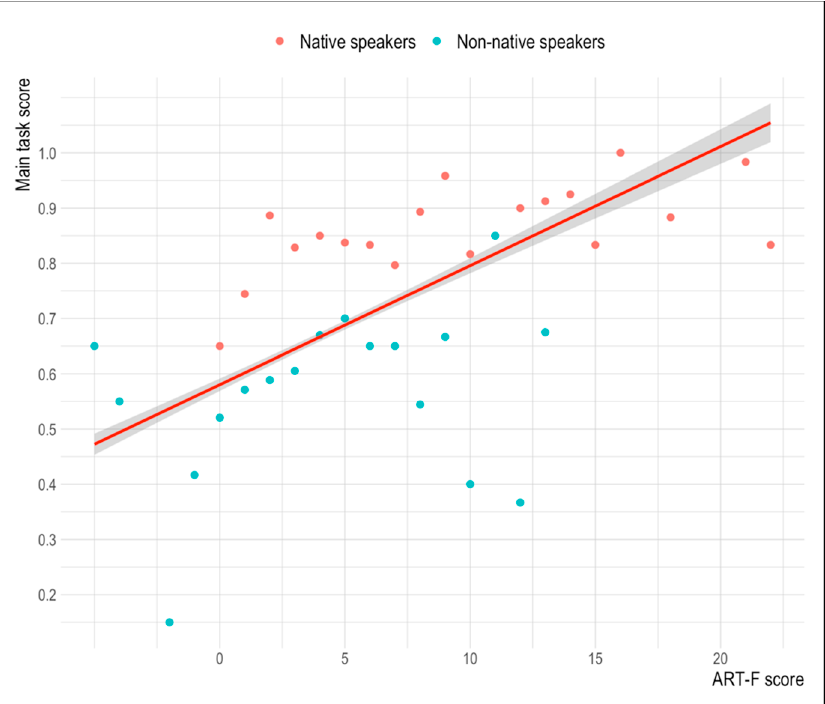
Figure 10. Relation between the scores in the main task and in the French author recognition task by native and non-native participants .